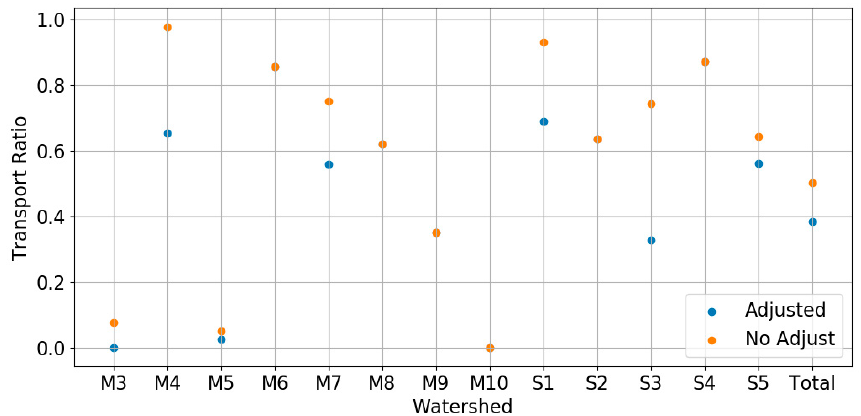
Figure 12. The transport ratio for each individual watershed for the 50-year event.